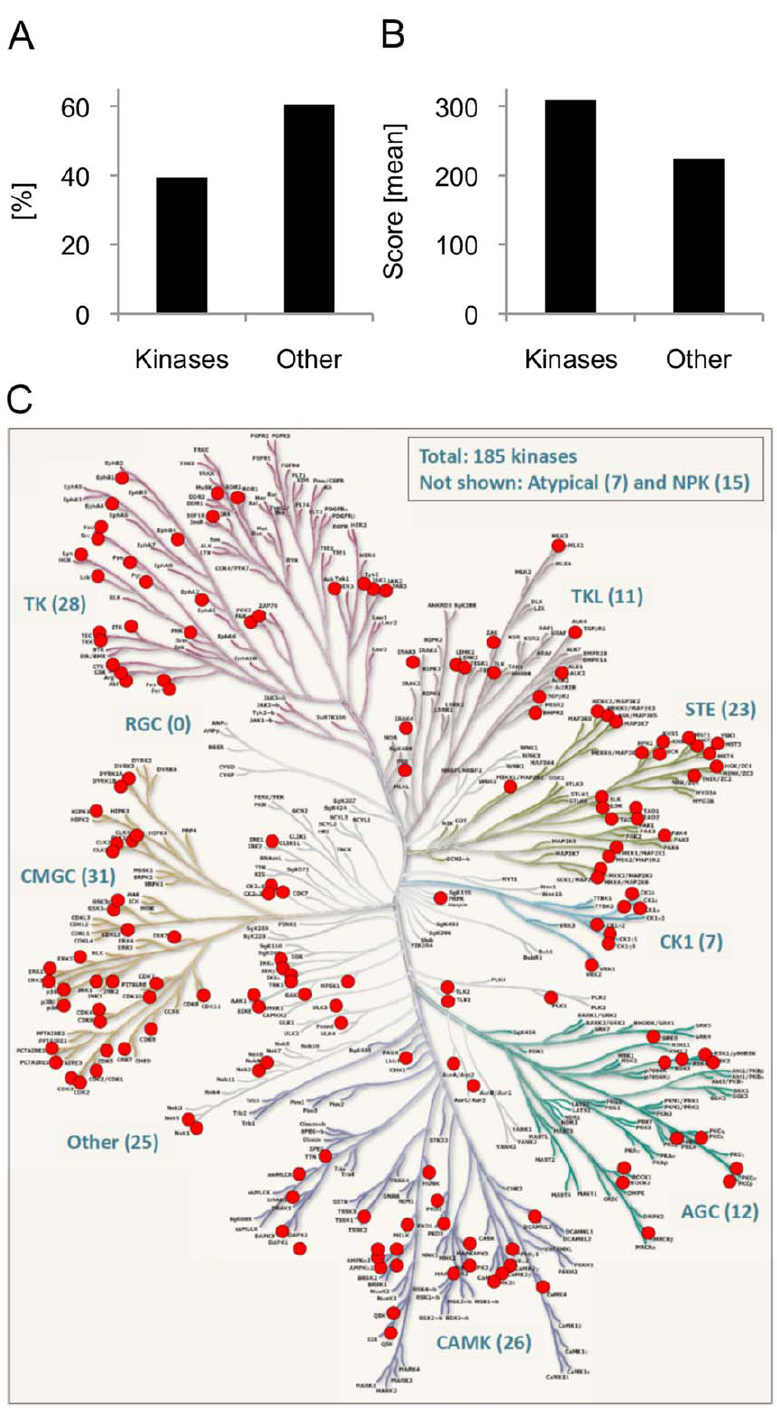
Figure 3. Kinase-selective proteomics provided comprehensive insight into the kinase complement of human Tregs and Teffs. ( A ) Enrichment of kinases. Percentage of kinases and non-kinases (others: proteins without kinase activity) after VI16743/Purvalanol-B-mediated affinity purification is shown. ( B ) Quality of kinase identification. Mean Mascot Mowse score of kinases vs . non-kinases (others). The Mascot score is reflecting the probability of the match between the mass spectrometry spectra/data and the protein sequence given in the database. Data shown in A and B are representative for four independently performed LC-MS/MS experiments. ( C ) Kinase complement of human Tregs and Teffs. In total, 185 kinases were identified. Kinases from nearly all groups of the human kinome were detected: AGC, PKA/PKG/PKC-family kinases; CAMK, calcium/calmodulin- dependent kinases; CK1, casein kinases; CMGC, CDK/MAPK/GSK3/CLK-family kinases; RCG, receptor guanylate cyclases; STE, sterile homologue kinases; TK, tyrosine kinases; TKL, tyrosine kinase-like kinases; atypical protein kinases; Other, kinases belonging to non of the mentioned groups; NPK, non-protein-kinases (kinases having non protein substrates). The kinase dendrogram was adapted with permission from Cell Signaling Technology, Inc. (www.cellsignal.com).